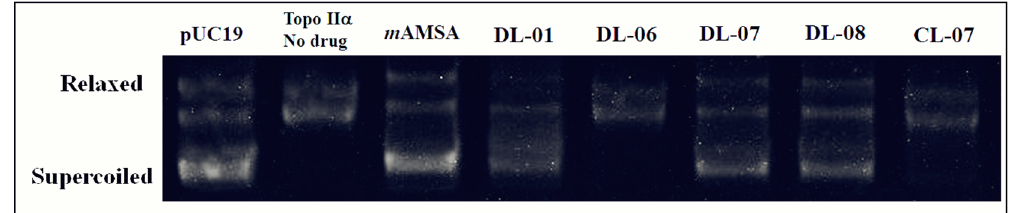
Figure 2. Effects of m AMSA and its acridine derivatives on topoisomerase II α activity. Effects of derivatives and positive control on the inhibition of human topoisomerase II α . Native supercoiled pUC19 was incubated for 30 min at 37 °C with 2 units of human Topo II α in the absence (lane 2) or presence of ligands at a concentration 100 µM. Inhibition of Topo II α -induced DNA relaxation by m AMSA (lane 3) was used as a positive control. DNA samples were run on an agarose gel followed by ethidium bromide staining. Table 2. Topo II α inhibition activity of acridine derivatives.